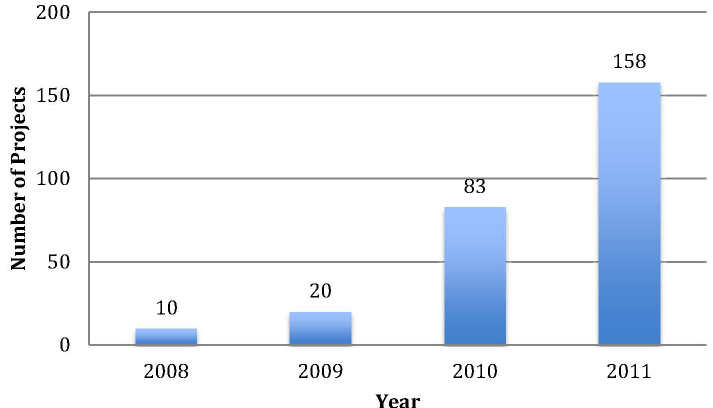
Figure 1. Number of Green Commercial Building Projects in China, 2008–2011. Source: